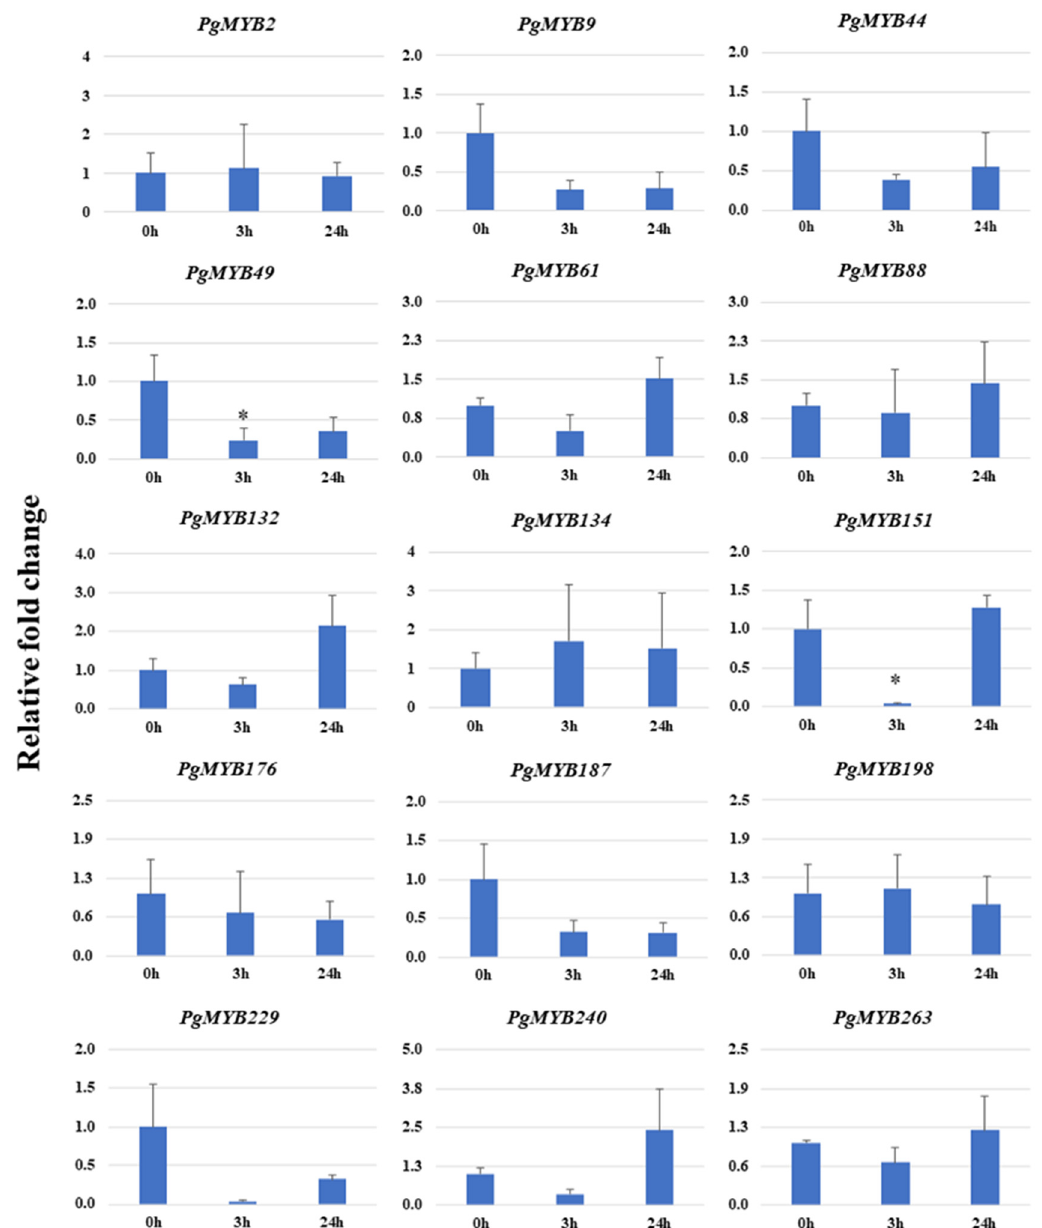
Figure 7. Relative expression analysis of PgMYB genes under salinity stress at 0 h, 3 h and 24 h time points. The X -axis represents different time points and the Y -axis indicates relative expression level.